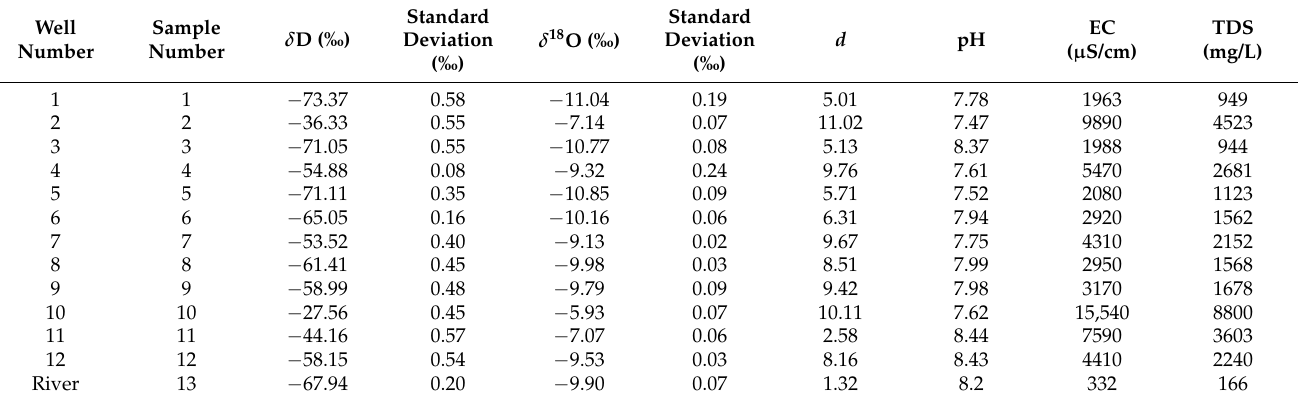
Table 2. Test results of the stable hydrogen/oxygen isotope and the water quality parameters of the water samples.